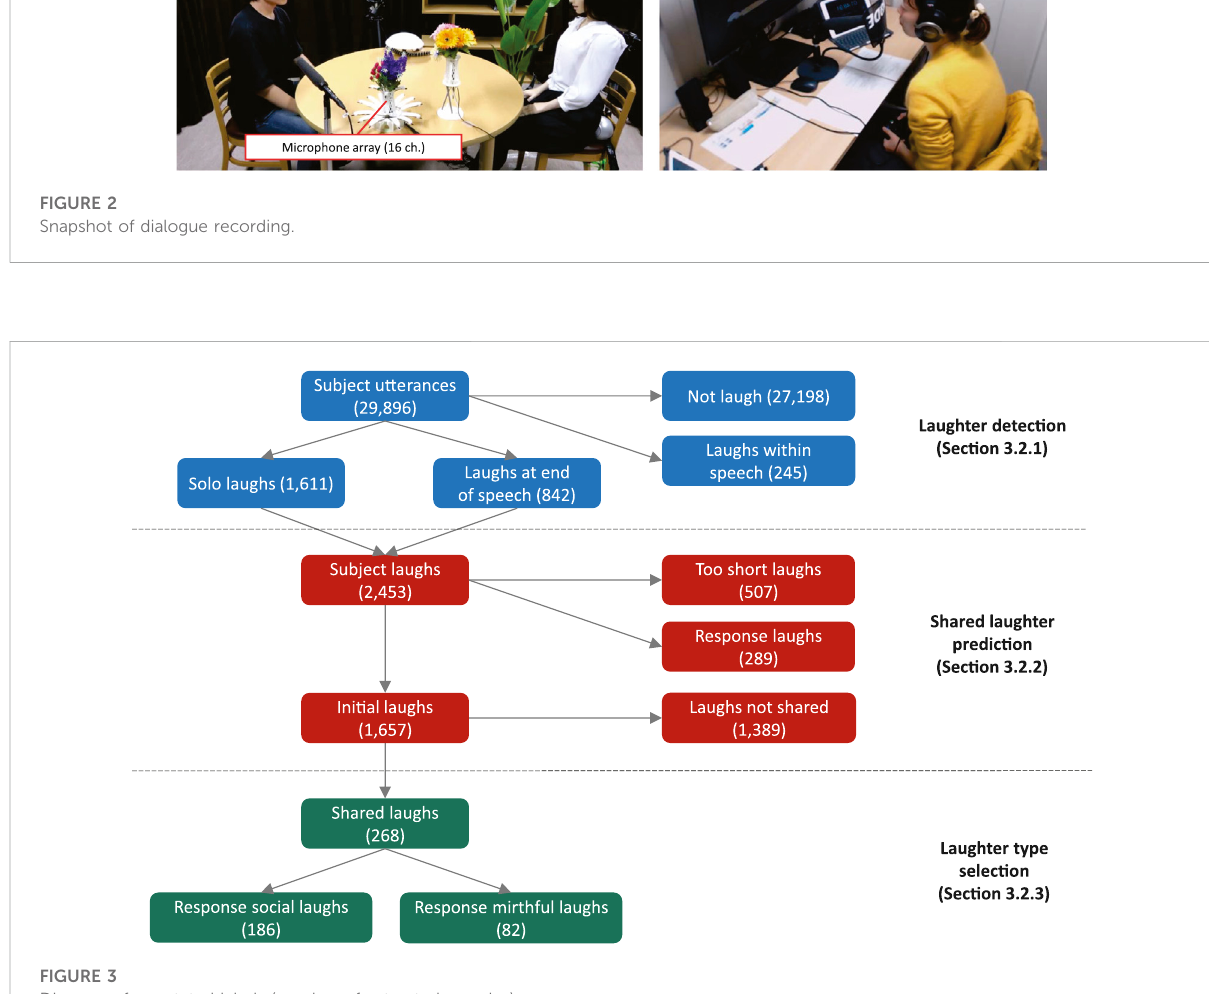
FIGURE 3 Diagram of annotated labels (number of extracted